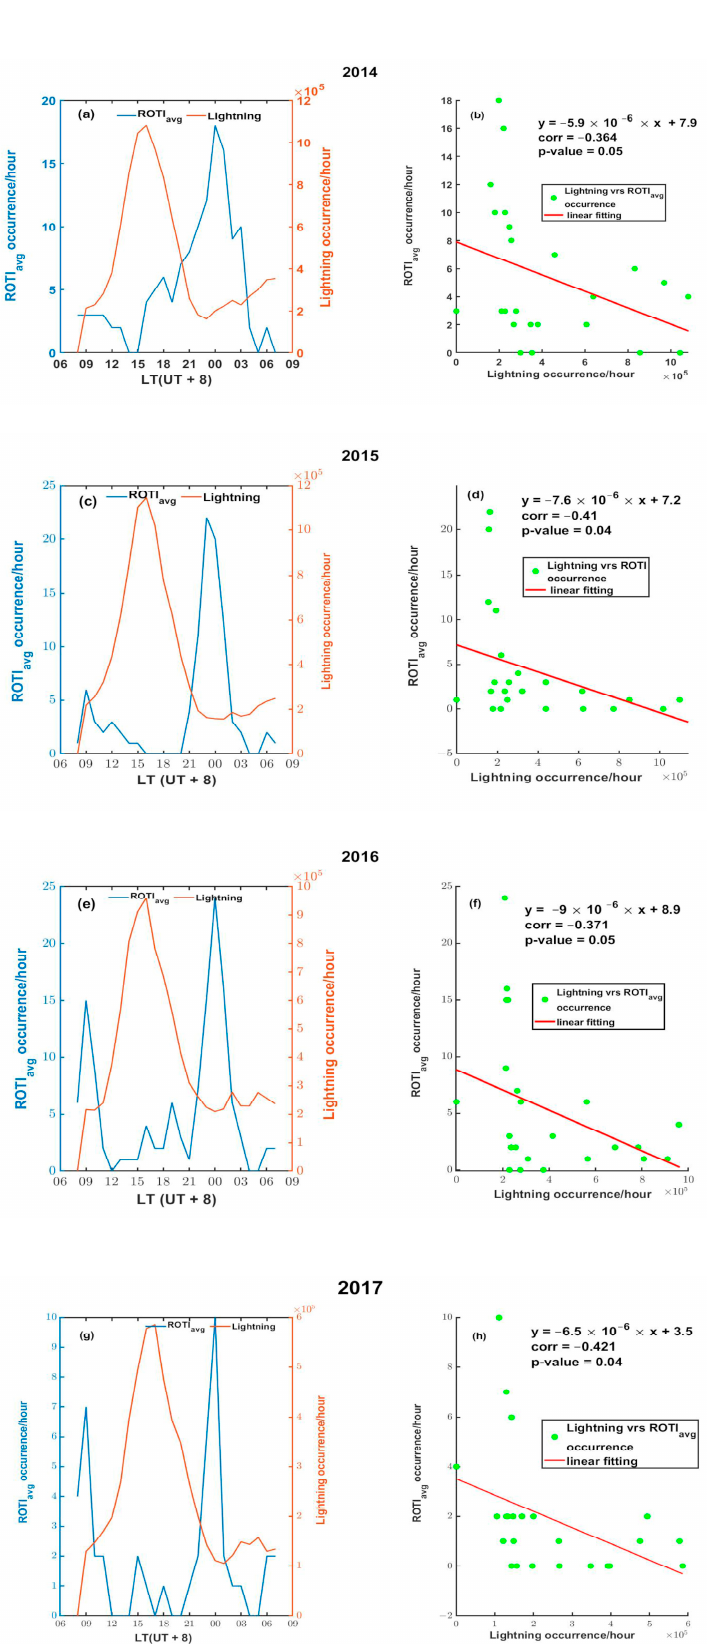
Figure 2. Panels in the left column ( a – d ) show the diurnal hourly occurrence of ROTI avg and lightning. Panels in the right column ( e – h ) are scatter diagrams showing the linear correlation between the diurnal hourly occurrence of lightning and ROTI avg for the respective